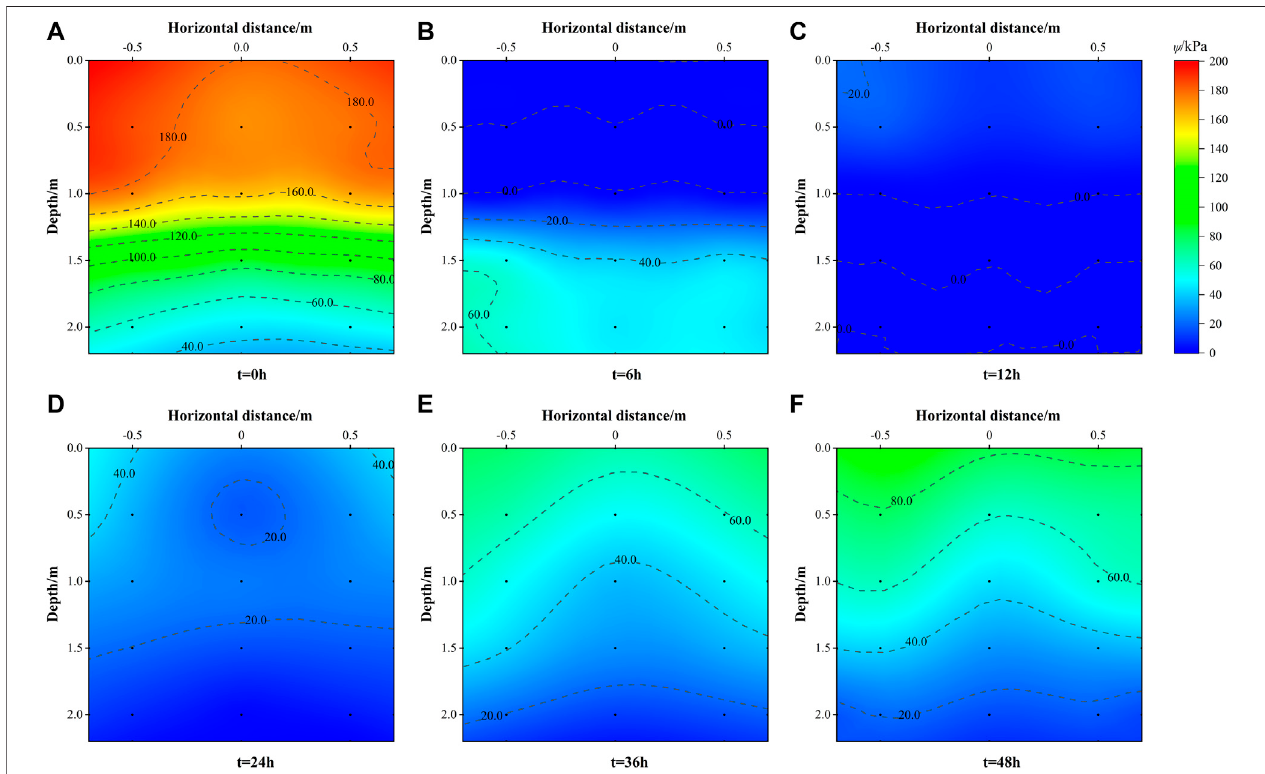
FIGURE 16 | The isolines of matrix suction on section at different times. (A) t = 0 h (B) t = 6 h (C) t = 12 h (D) t = 24 h (E) t = 36 h (F) t = 48 h.